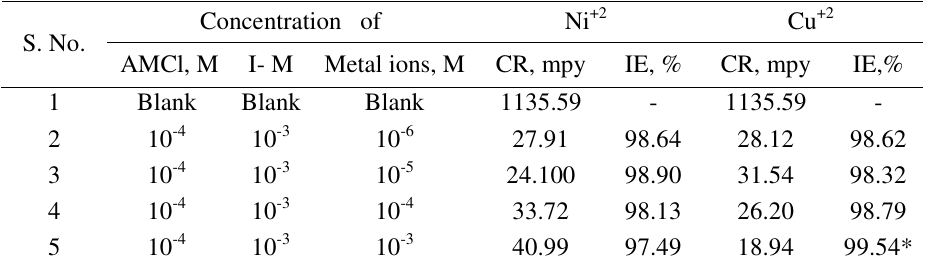
Table 6. Tabulation of Cr and IE for the various concentrations of different metal ions(Ni 2+ & Cu 2+ ) with 10 -4 M AMCl and 10 -3 M bromide in 1M H Concentration of